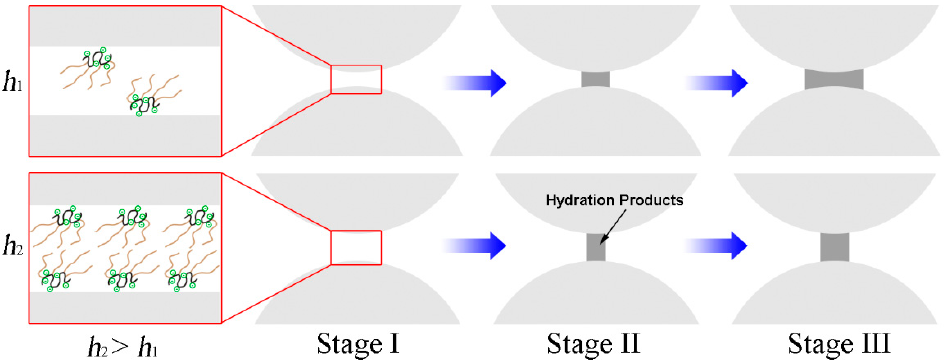
Figure 7. Effect of superplasticizer on thixotropic structural build-up behavior: low surface coverage ( top ) and high surface coverage ( bottom ), with equal amounts of early hydration products at different stages.